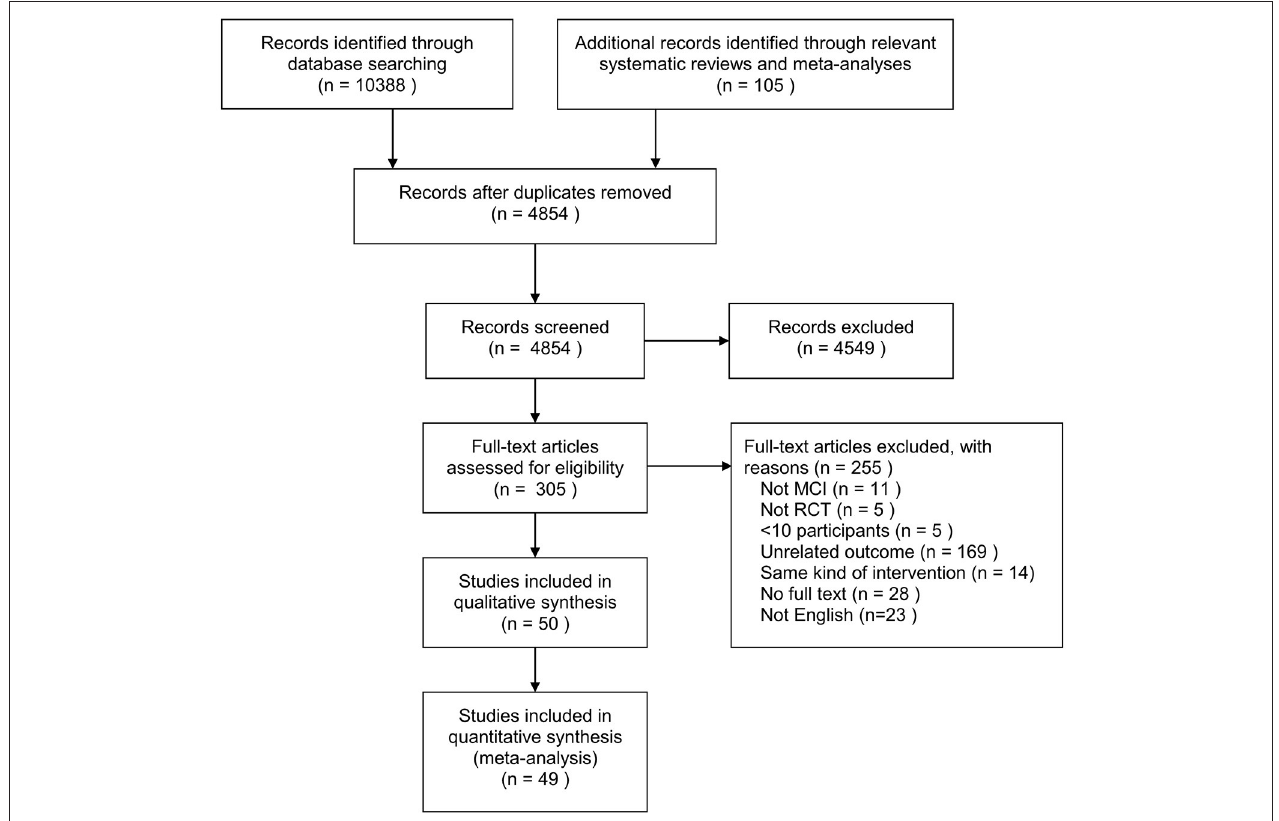
FIGURE 1 | Flow chart of the